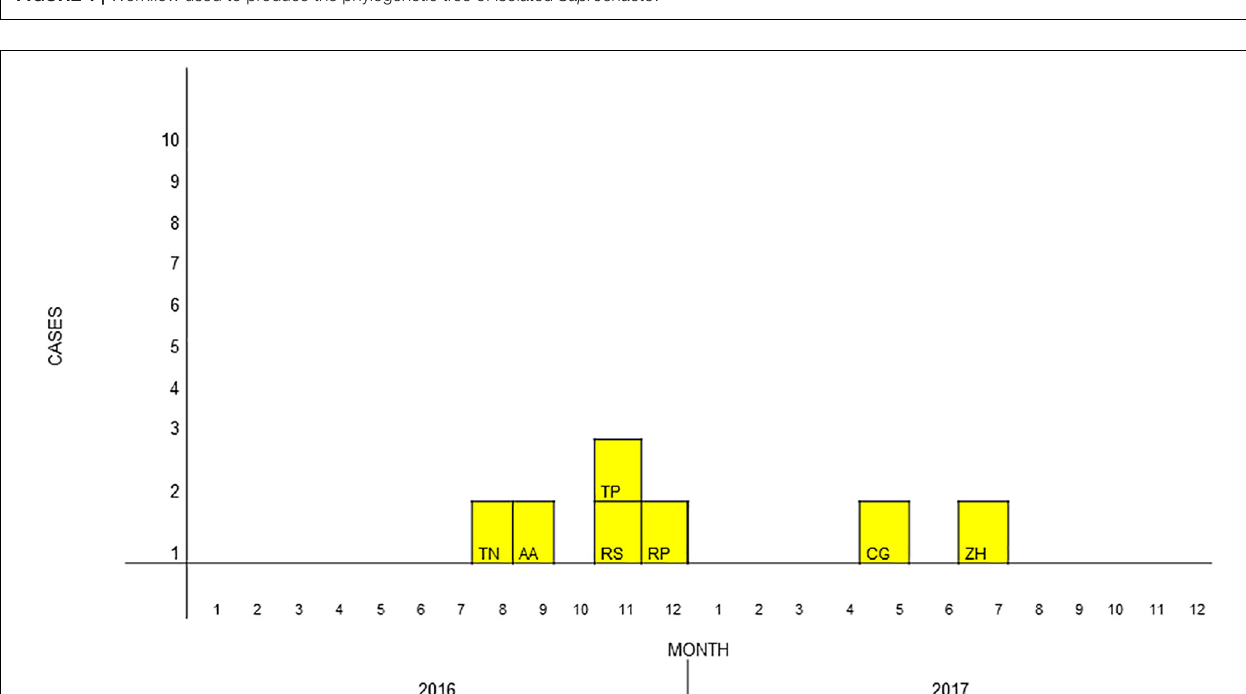
FIGURE 2 | Epidemiological curve of Saprochaete clavata infections. The cases are designated with letters which identify the isolate, with boxes corresponding to the date of the first positive blood culture.